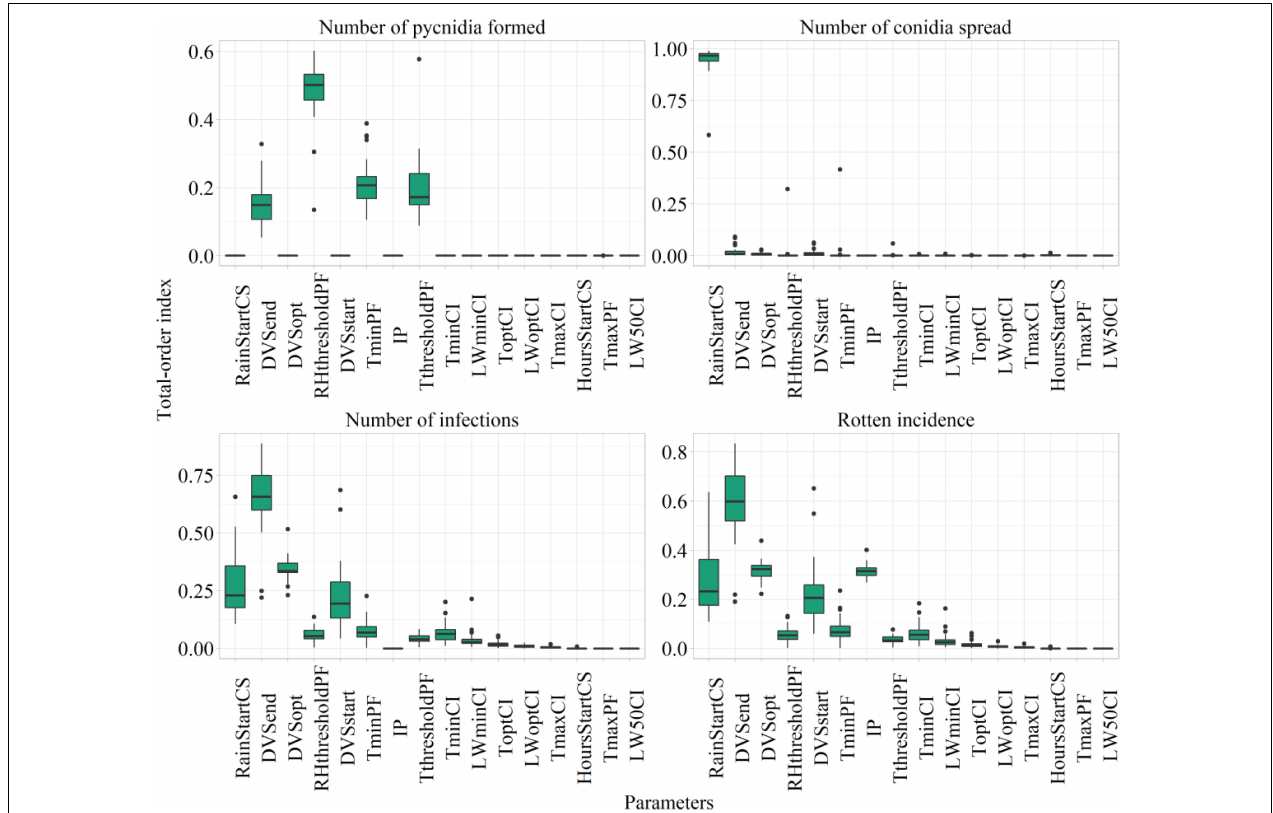
FIGURE 6 | Sobol total sensitivity index (STI) from Sobol sensitivity analysis considering main model outputs. The description of the parameters is presented in Table 3 .